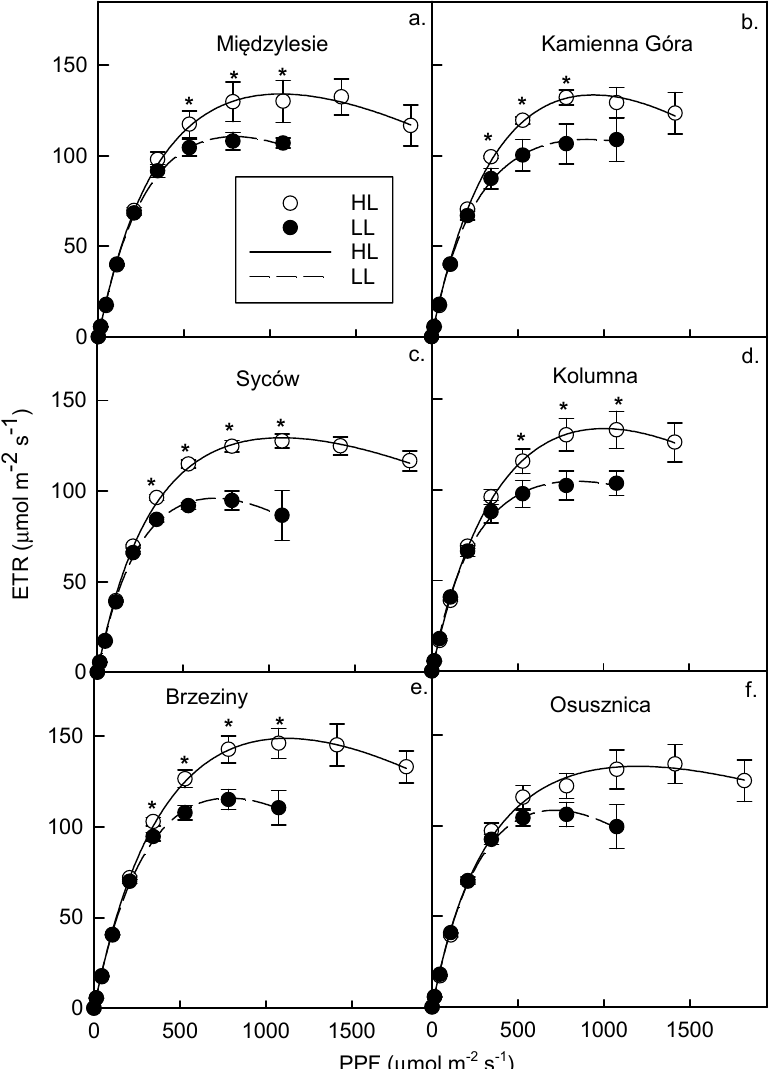
Figure 4. Light curves of apparent electron transfer rate ( ETR ) in needles of Abies alba seedlings originating from different provenances and acclimated to full irradiance or shade. Mean values ( ± SE) of ETR are shown separately for each provenance in plots ( a – f ) in shade and in full irradiance. An asterisk indicates that mean values of ETR at the given actinic PPF value are significantly different using Student’s t- test at p < 0.05 ( n = 5). PPF —photosynthetic photon flux.